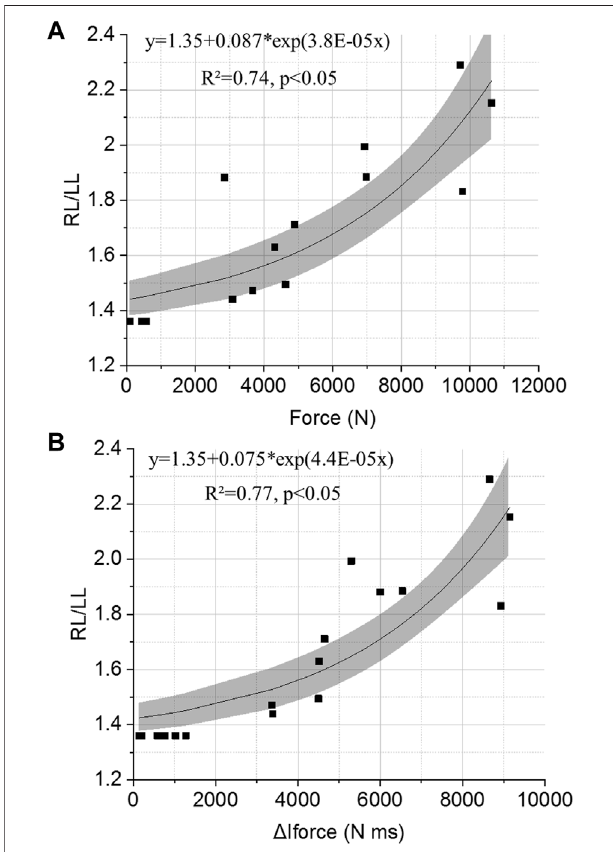
FIGURE 8 | Relationship between the risk of lung injury (right-to-left lung weight ratio, RL/LL) and BOPMAN measured parameters: (A) Force and (B) Δ I fi t equations are given on the FORCE . Exponential